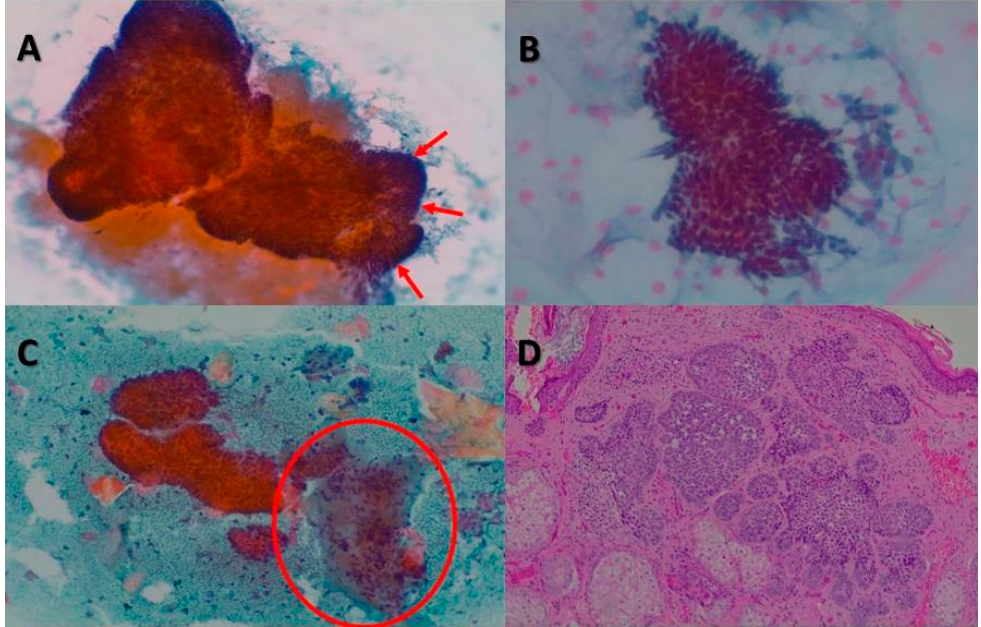
Figure 2. BCCs. ( A ) Cytology revealed large clusters of basal cells, mucin, and peripheral cells arranged in palisades (red arrows) (Papanicolaou stain, ×100). ( B ) Cytological image with a fragment composed of small basal cells with uniform oval, dark nuclei (Papanicolaou stain, ×200). ( C ) Group of basal cells accompanied by a stromal fragment (red circle) and keratinized squamous cells (Papanicolaou stain, ×100). ( D ) On histology, BCC showed a lobular pattern with islands and basaloid cells (hematoxylin and eosin, ×40).